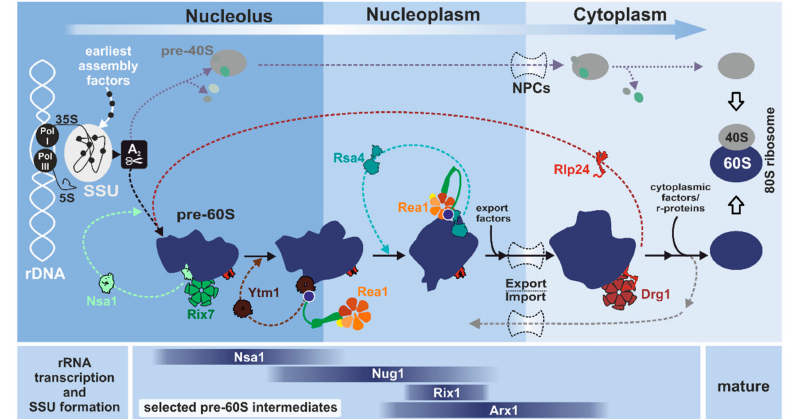
Figure 1. Eukaryotic ribosome biogenesis—a sophisticated assembly line. Ribosome biogenesis begins with the transcription of the ribosomal RNA (rRNA) in the nucleolus. At this stage, the first